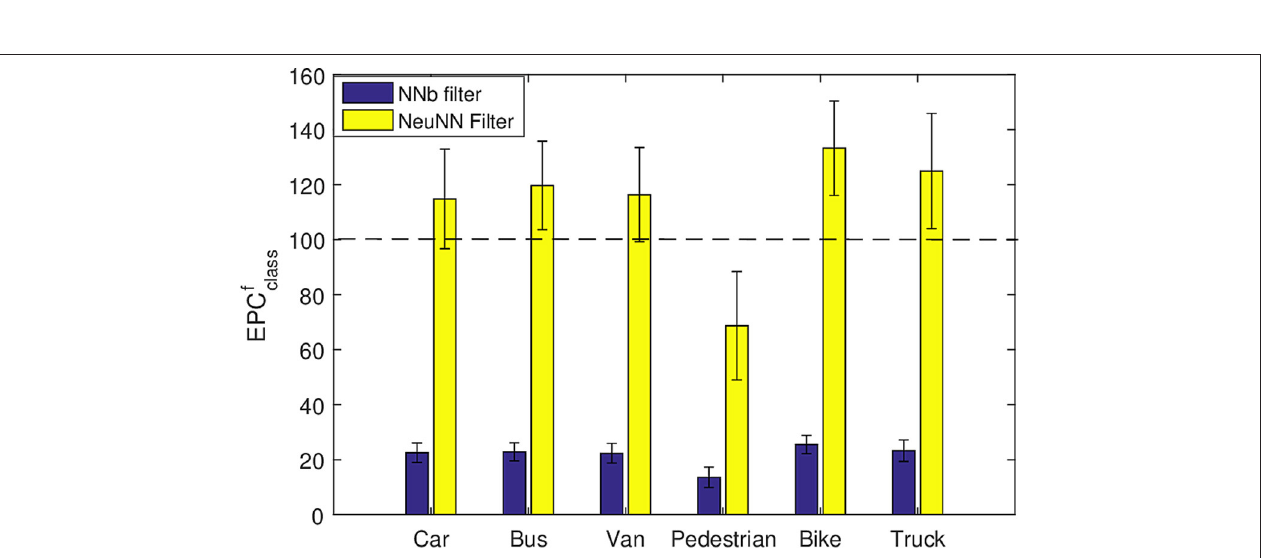
FIGURE 9 | Average percentage of signal events remaining compared with the original data for each class after two-layer filtering using all the samples in Table 1 .